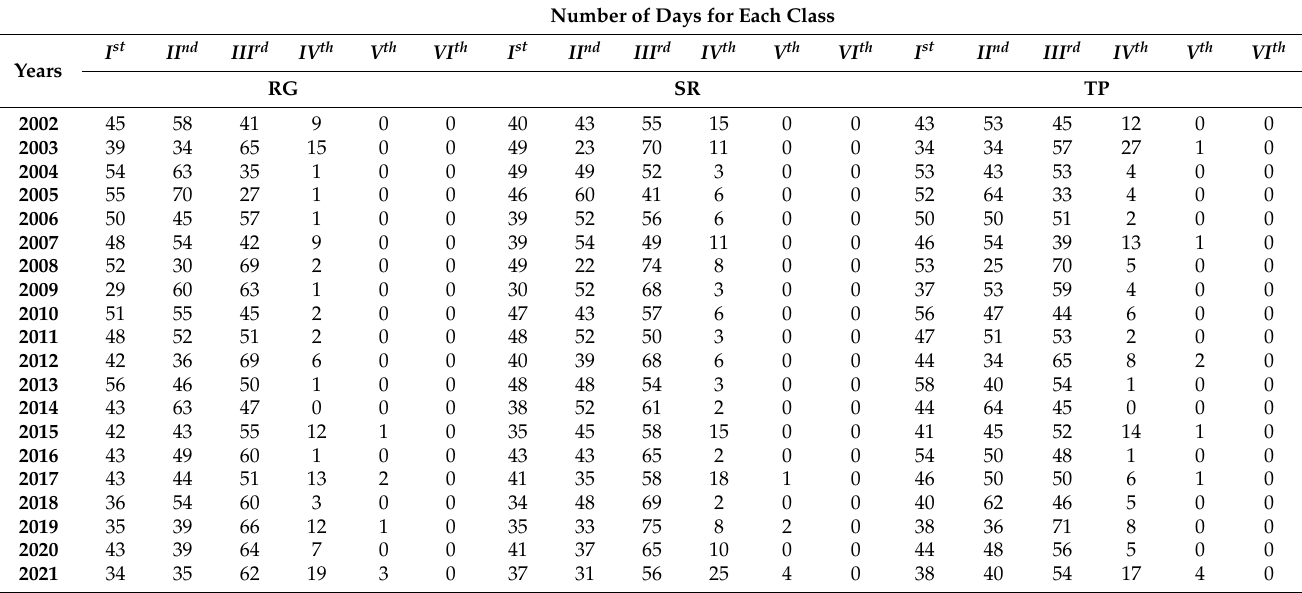
Table A2. Annual distribution of the number of days in each TDI class for the provinces of RG, SR, and